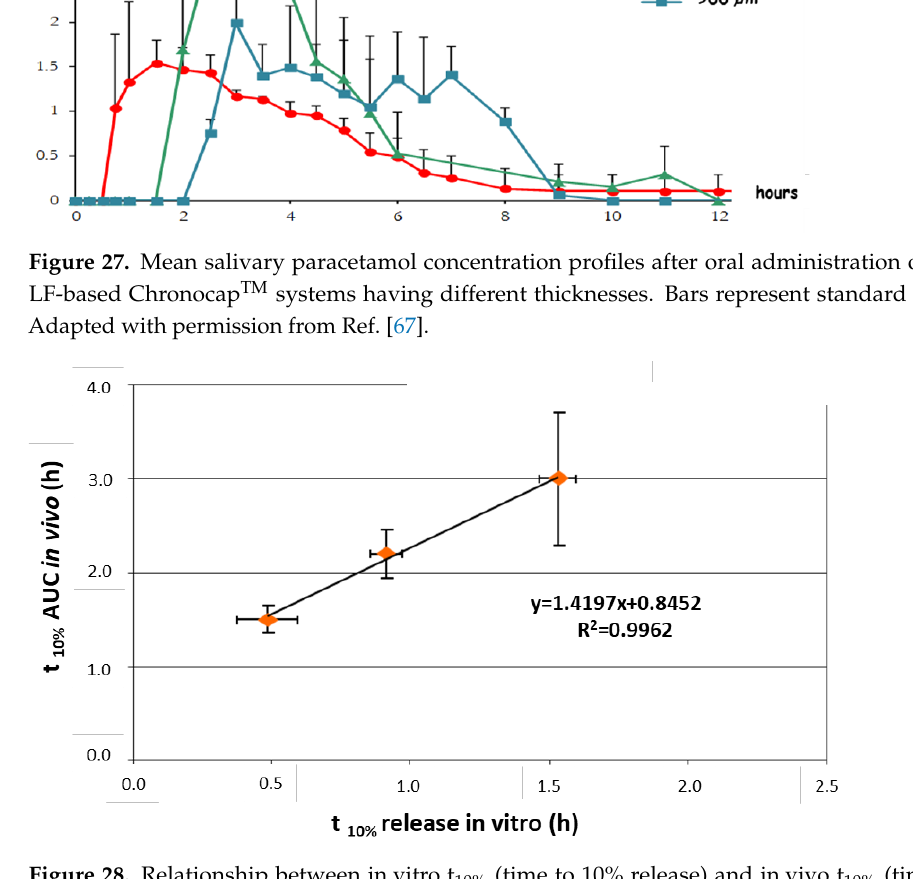
Figure 28. Relationship between in vitro t 10% (time to 10% release) and in vivo t 10% (time to 10% AUC) for Klucel ® LF-based Chronocap TM systems having increasing thicknesses. Adapted with permission from Ref. [67].